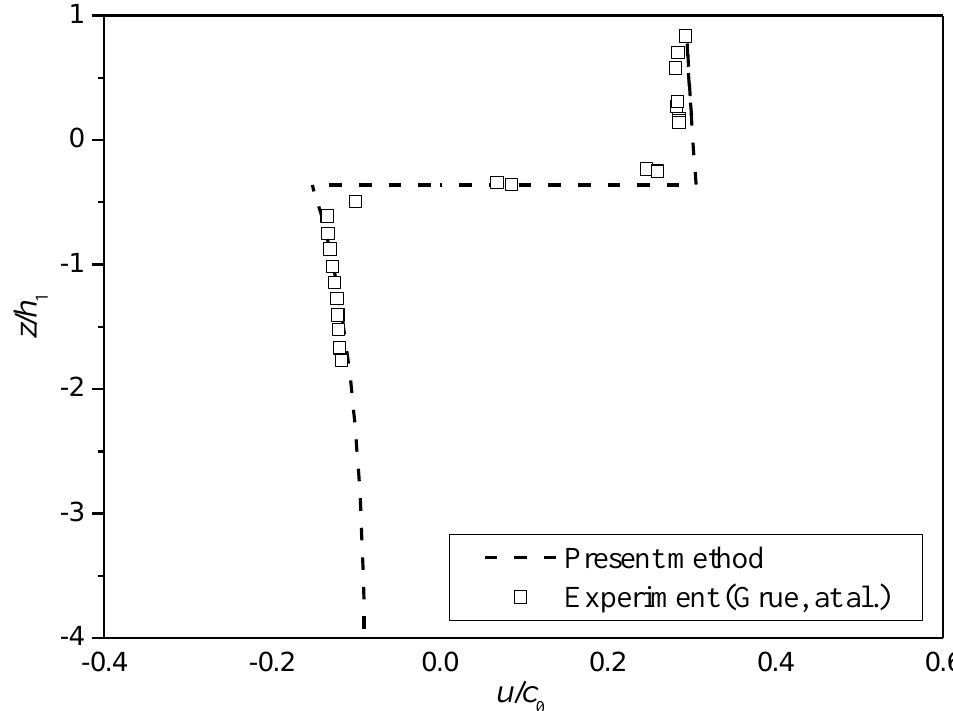
Figure 6. The fluid horizontal velocity distribution in the inner region of internal solitary waves flow field and the comparison with literature [48].